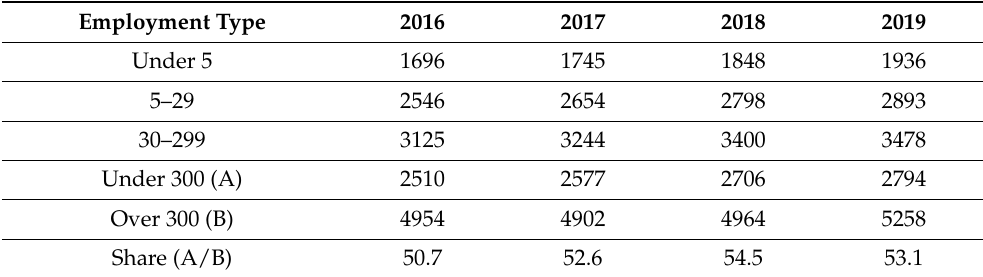
Table 3. Monthly gross income by firm size. Unit: KRW 1000, %.